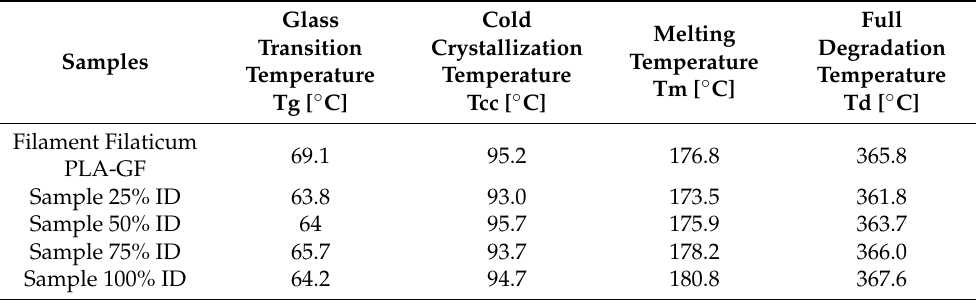
Table 3. Differential Scanning Calorimetry (DSC) results for PLA-GF filament and AMed